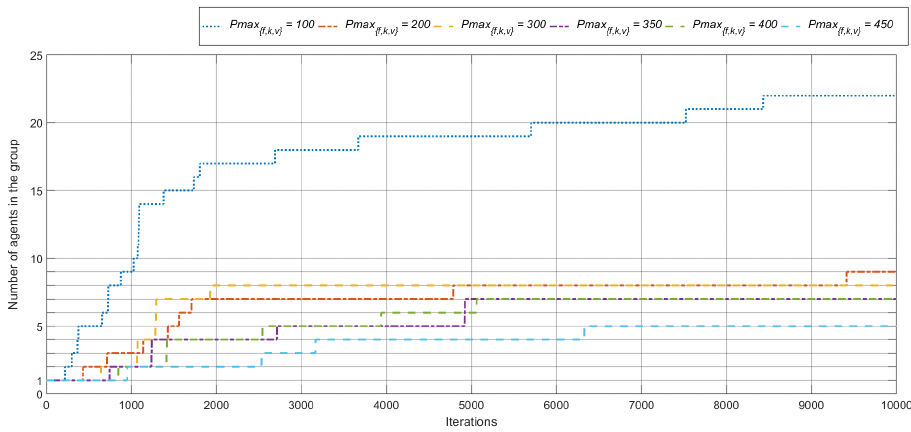
Figure 6. Adding the agents to the group for various parameter settings: TCa { f , k , v } = 0, TRa { f , k , v } = 70% from Pmax { f , k , v } , and TPea { f , k , v } = 3 ∗ Pmax { f , k , v } .